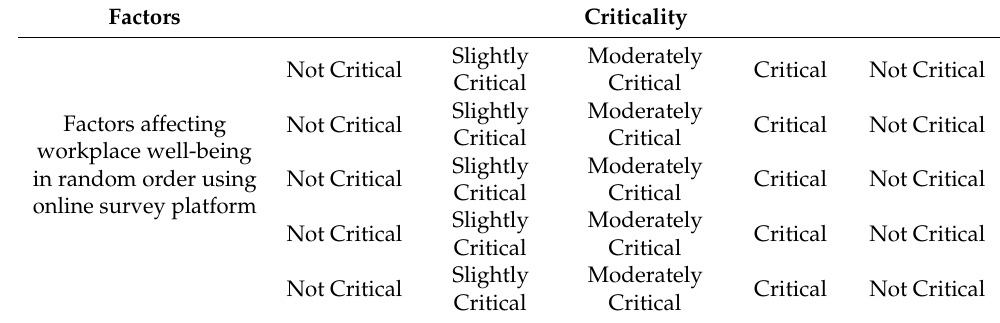
Table A1. Please rate the criticality of the following factors that are affecting workplace well-being in building construction projects.